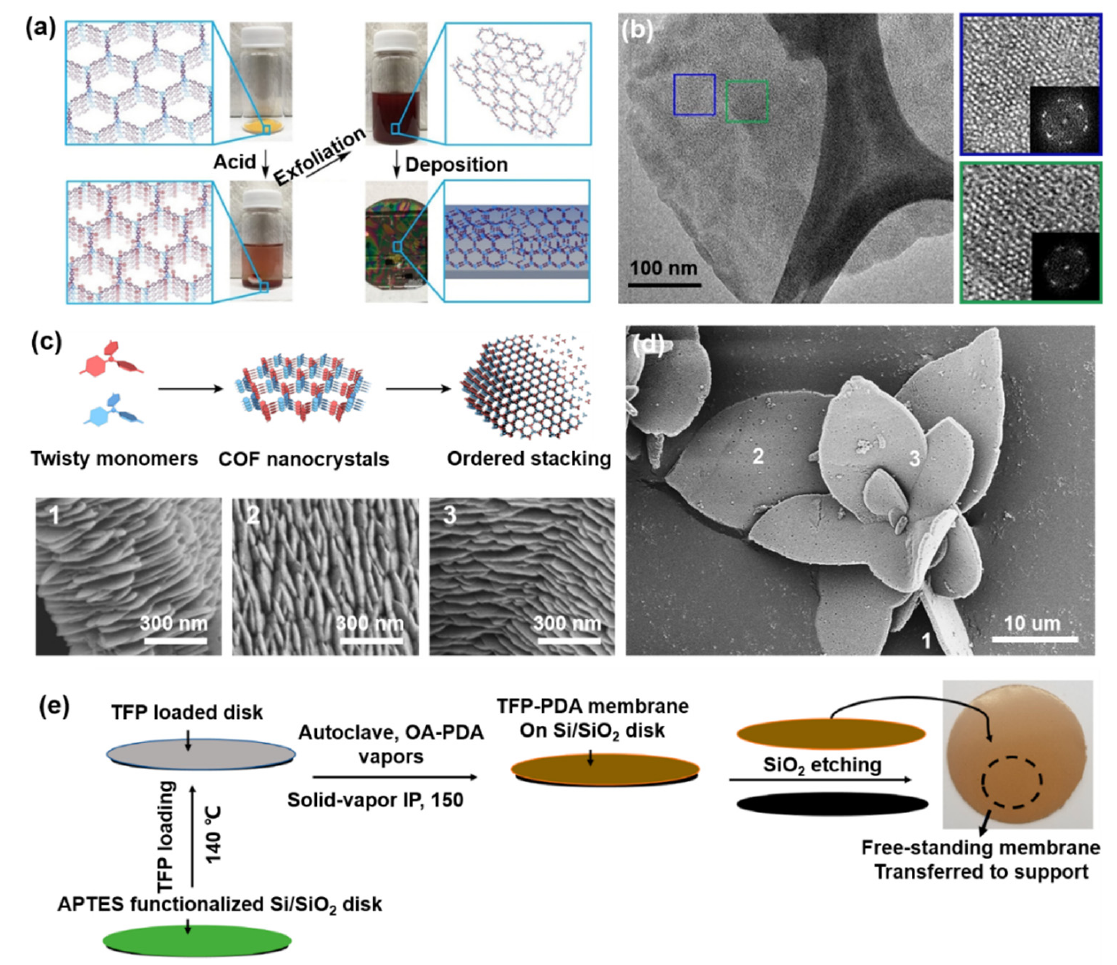
Figure 6. Specific COF structures can be constructed via different synthesis strategies. ( a ) Overview of the acid-exfoliation and film-casting procedures. ( b ) HRTEM image of an exfoliated BND–TFB COF sheet [92]. Copyright 2019, Wiley-VCH. ( c ) Schematic illustration of employing twisty monomers to achieve ordered stacking for producing long-range ordered COF assemblies. ( d ) FESEM images of flower-shaped TAPA–TFPA COF assemblies at different scales [93]. Copyright 2021, American Chemical Society. ( e ) Solid-vapor IP for the TFP–PDA membrane, including membrane growth and HF etching step to obtain free-standing membrane [94]. Copyright 2020, American Chemical Society. The top-down preparation method can obtain thin-layer COFs without destroying the original morphology and can easily prepare COFs suitable for different application environments. However, the huge material waste caused by it cannot be ignored, and